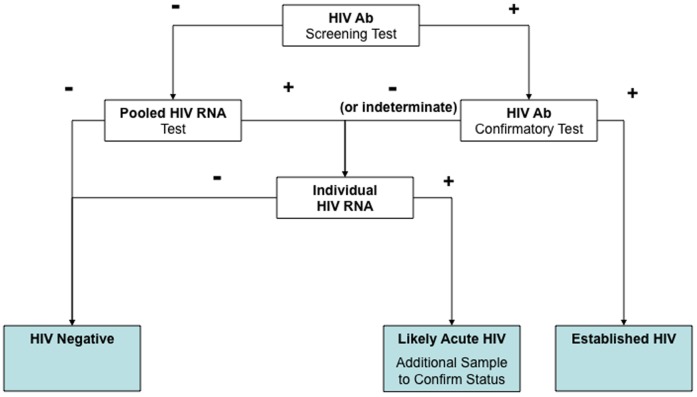
Clinical Testing Algorithm, San Francisco Targeted Testing Programs 2003–2008 (adapted from [6]).